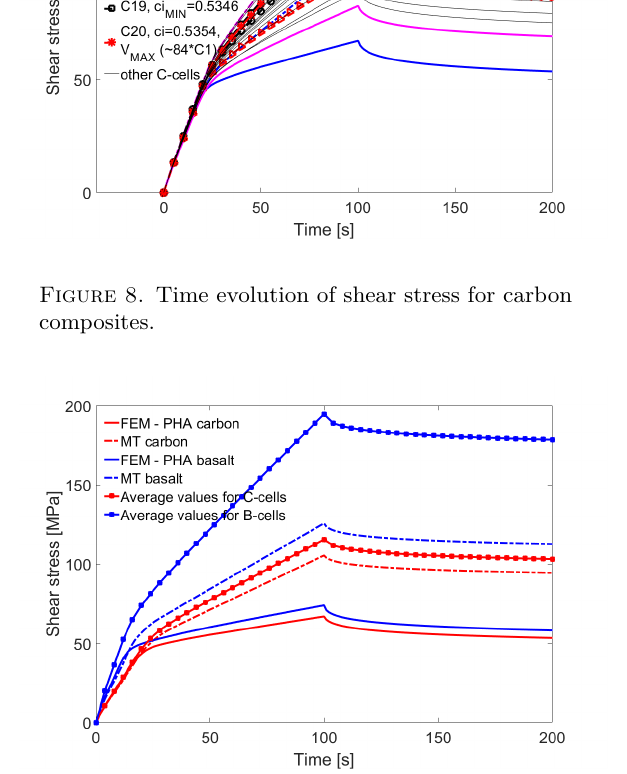
Figure 5. Shear stress - strain diagram for basalt composites.